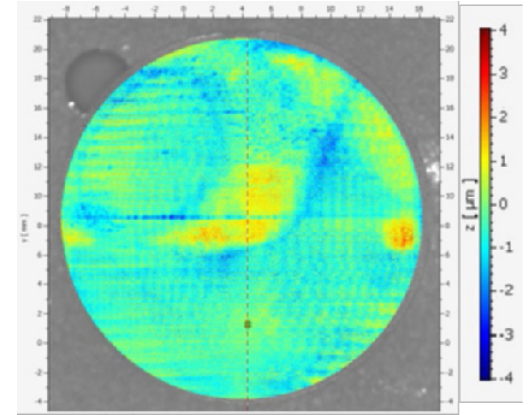
Fig. 3. Difference topography of a grinded fused silica Alvarez freeform ( ø 1 inch) measured by white light